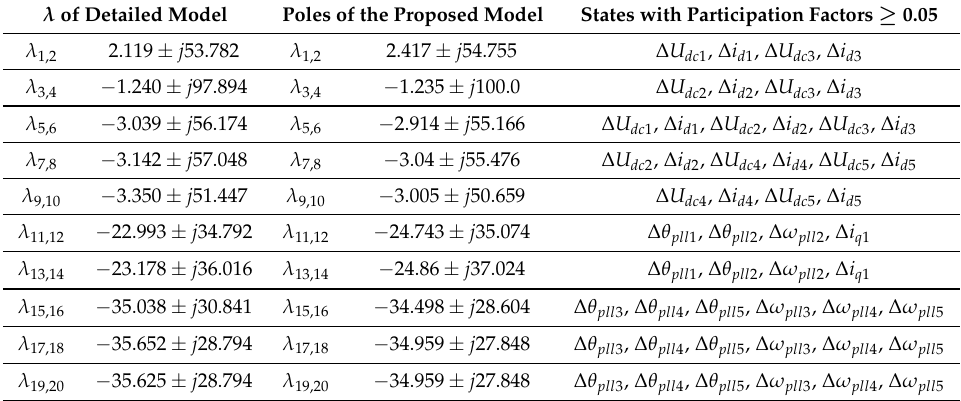
Table 1. Eigenvalues of the model except for real roots.